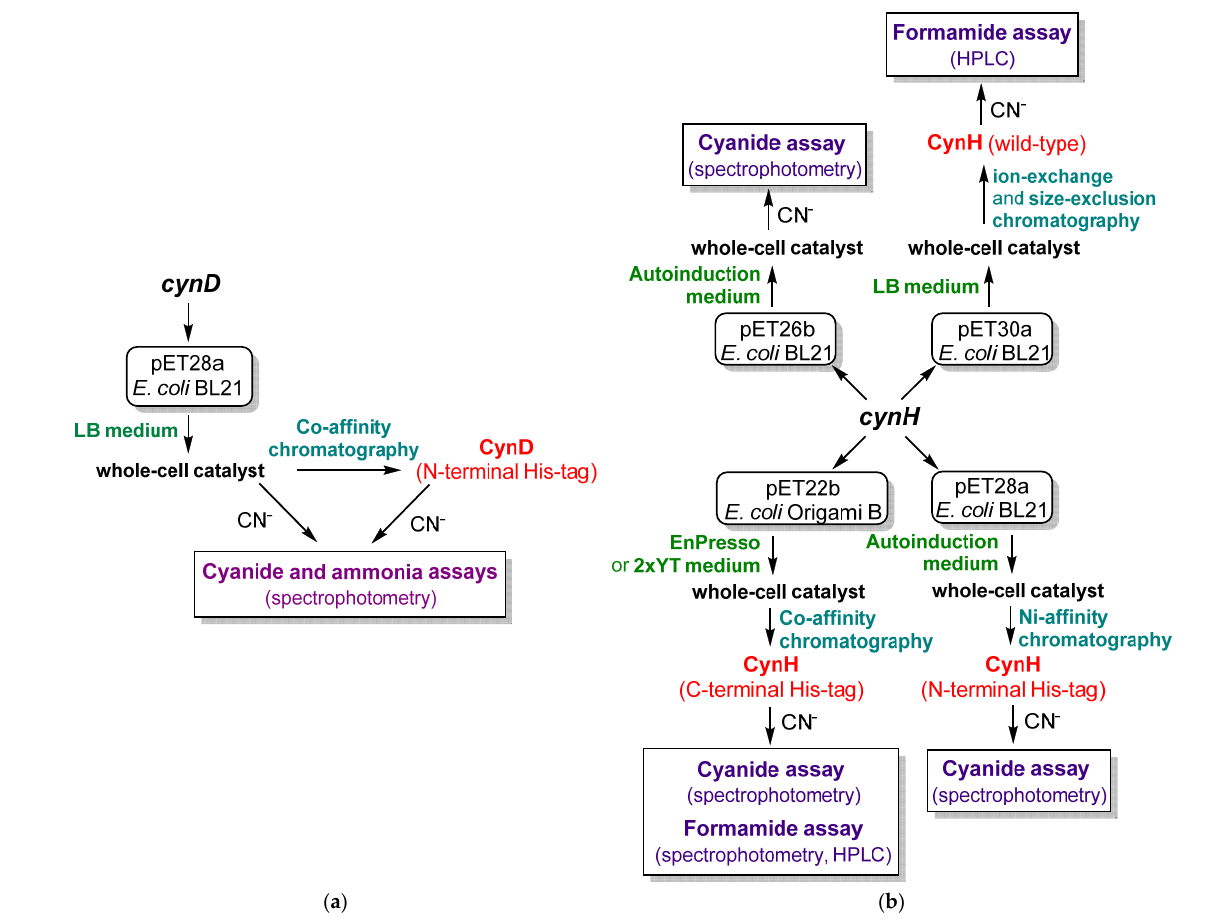
Figure 4. Summary of the methods used for the production, purification, and activity assays used for ( a ) cyanide hydratases (CynDs) and ( b ) cyanide hydratases (CynHs). See Tables 3 and 4 for the details of gene expression and activity assays,